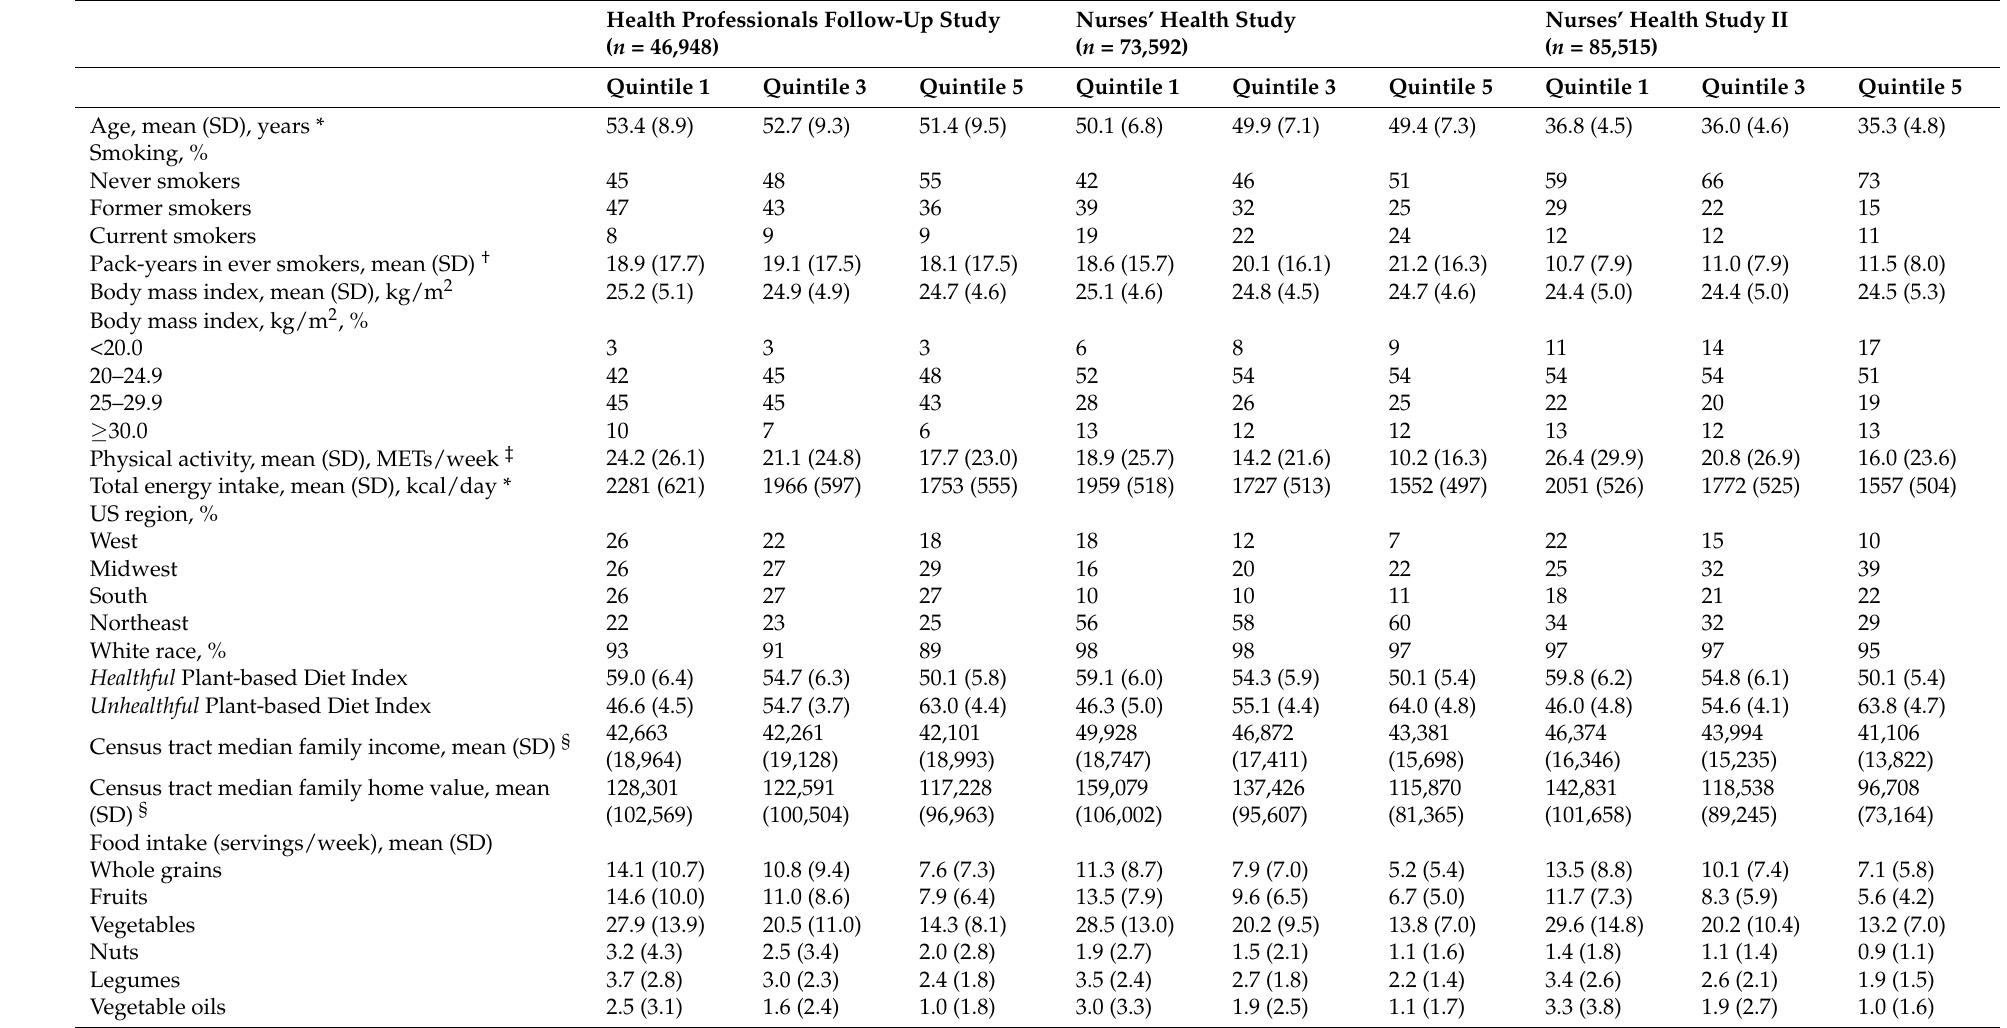
Table 2. Baseline characteristics in participants according to quintiles of unhealthful Plant-based Diet Index